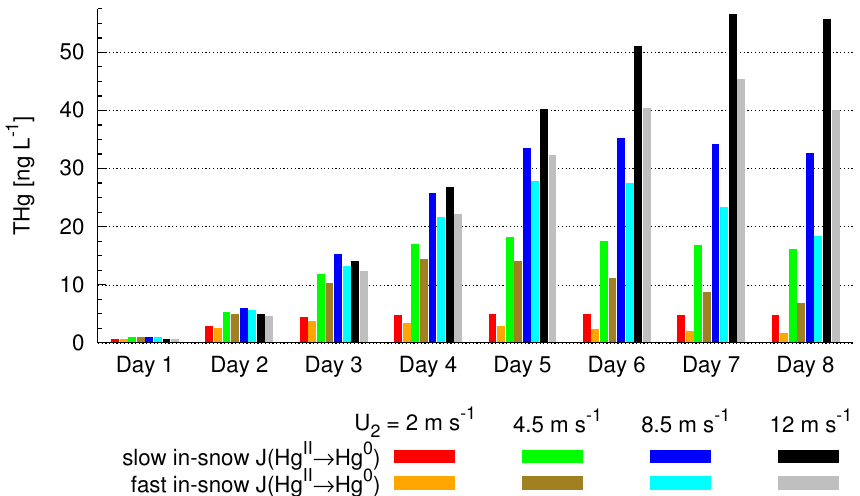
Fig. 15. Total concentrations of dissolved mercury averaged in the top 3cm of snowpack at the end of each day (from day 1 to day 8) as simulated in model runs employing scenarios 1A and 1B (“slow” and “fast” in-snow Hg(II) photo-reduction scenarios, respectively) at U 2 = 2 . 0 ms − 1 , 4.5ms − 1 , 8.5ms − 1 , and 12.0ms − 1 .